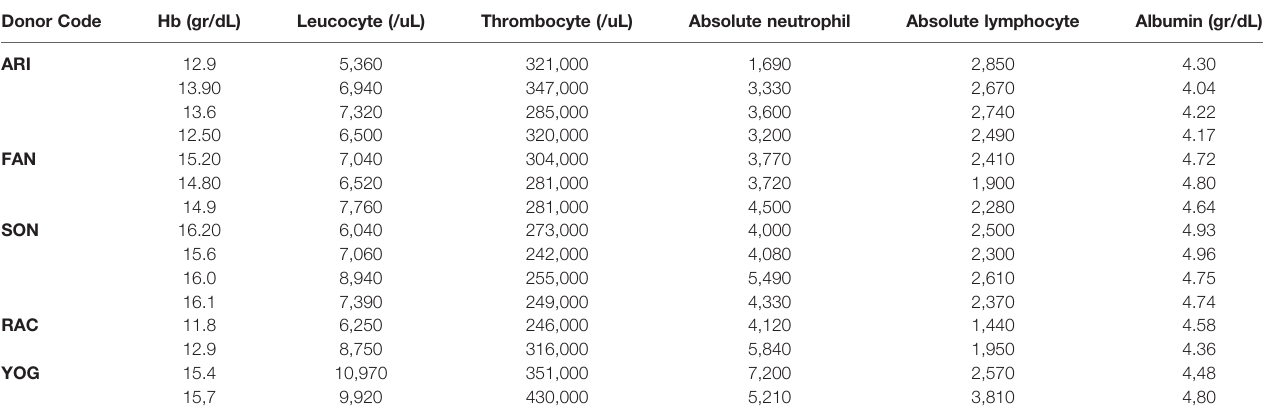
TABLE 4 | Laboratory results at convalescent plasma donation